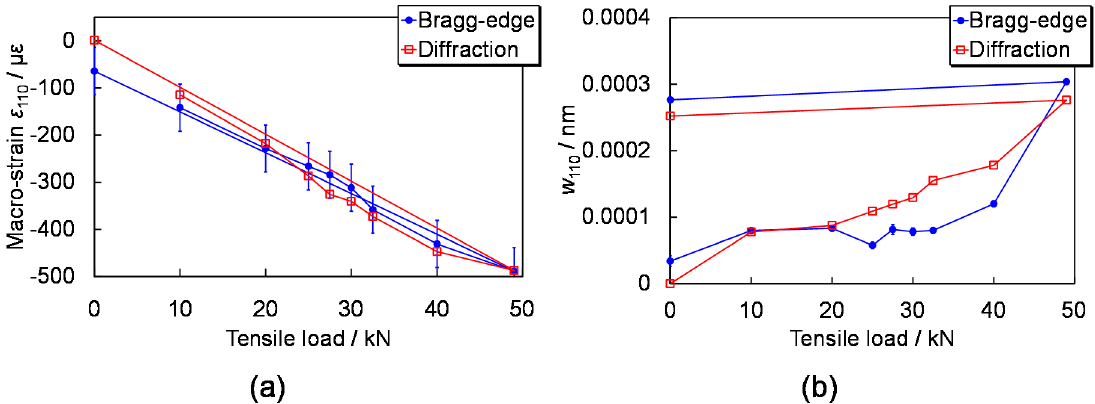
Figure 15. Comparison between Bragg-edge neutron transmission and neutron diffraction: ( a ) macro-strain [3] and ( b ) FWHM of d -spacing distribution relating to micro-strain [8].